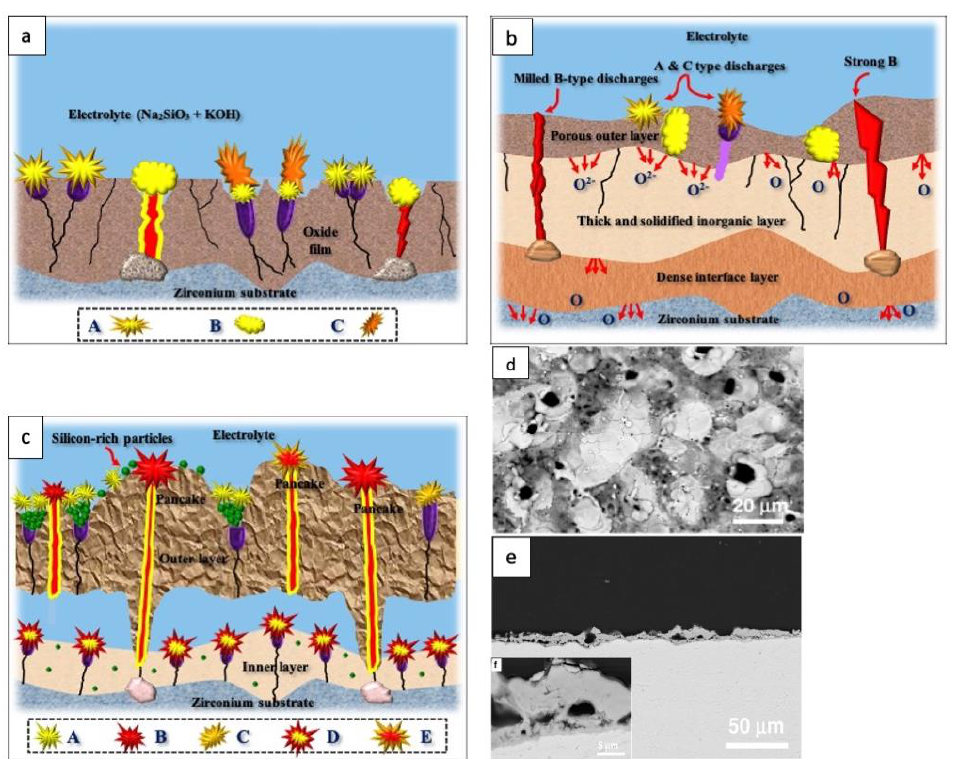
Figure 3. ( a ) Schematic illustration of the discharge types for the PEO coating on Zr in the silicate electrolyte based on the model suggested by Hussein et al. [21–23]; ( b ) Schematic representation of the discharge types for the PEO coating on Zr in the silicate electrolyte based on the model suggested by Cheng et al. [24]; ( c ) Effect of type B discharges on the surface morphology of the PEO coating on Zr substrate; ( d , e ) BS-SEM and cross-section image of the surface and the cross-section the PEO coating on Zircaloy-4 for 5 min at 100 Hz; ( f ) Magnified cross-section image from the coating shown in image ( e ) [28] (reproduced with permission number: 5043471384823, Elsevier).